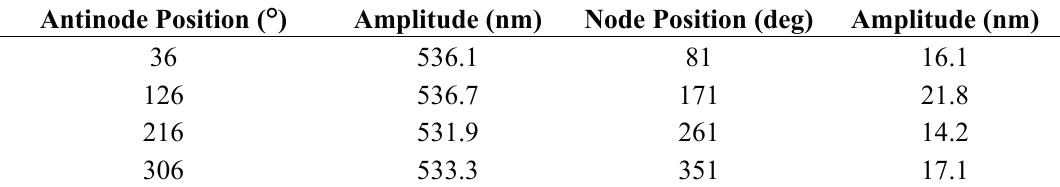
Table 3. The amplitude measured by a laser Doppler vibrometer.